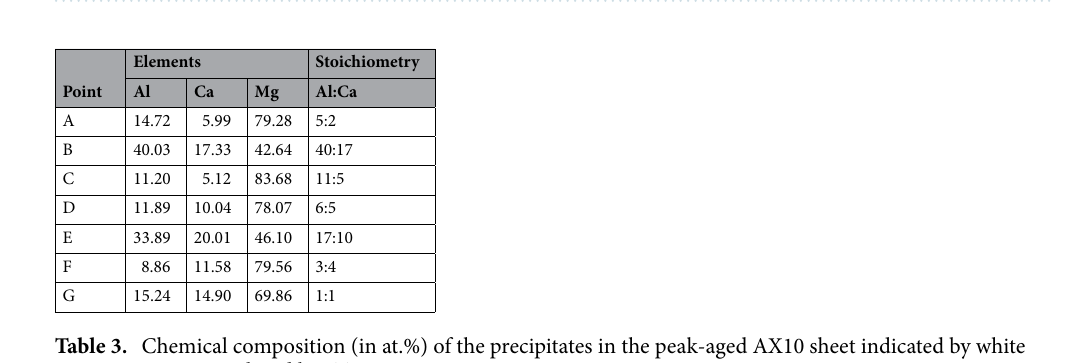
Figure 5. STEM images of the peak-aged ( a ) AX10 and ( b ) AXW100 sheet. The EDS results on the precipitates marked by arrows A to G in ( a ) and H to L in ( b ) are given in Tables 3 and 4, respectively.